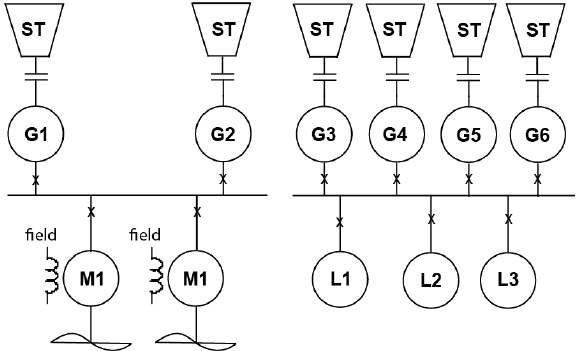
Figure 1. Traditional segregated ship power system with a propulsion power system and a service power system (ST—Steam Turbine, G—Generator, M—Motor and L—Load).